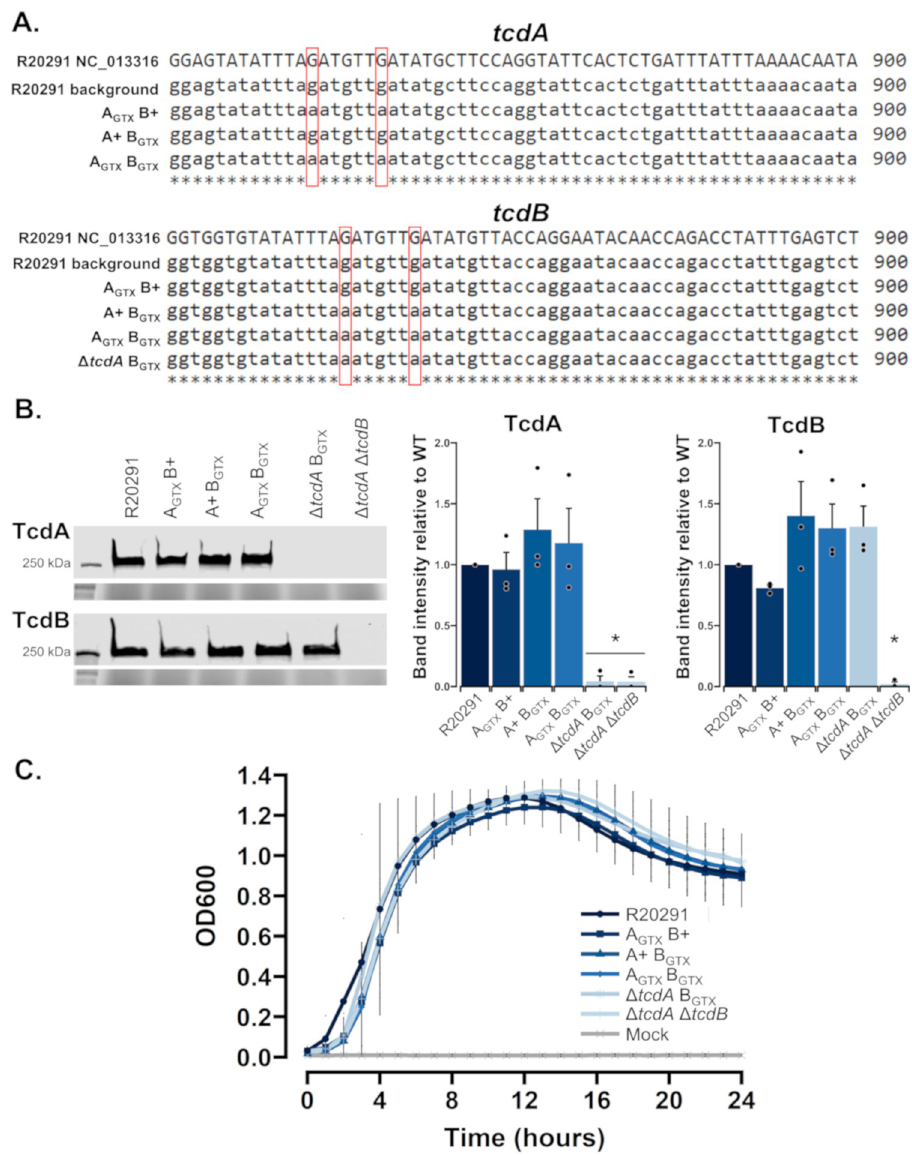
Fig 1. In vitro characterization of C . difficile mutants. (A) tcdA and tcdB gene alignments of mutant and wildtype strains to the reference genome of R20291. Red boxes highlight SNMs that deactivate GT catalytic activity. (B) Representative Western blot images of mutant and wildtype strains to confirm secretion (or lack thereof) of TcdA and TcdB. Images directly below each Western blot are stain-free gel images shown as loading controls. The graphs show densitometry analyses from Western blot experiments ( n = 3). Dots signify each replicate, bars denote the mean, and error bars represent the standard error of the mean. Significant differences were determined by Tukey’s HSD ( � p < 0.05). (C) In vitro growth curves of each strain and mock-inoculated controls ( n = 5 per treatment) cultured in BHIS for 24 hours. Dots are the average at each given timepoint, and the error bars depict the 95% confidence interval. Finally, we confirmed mutant and wildtype toxin function in vitro using cell rounding assays. Strain supernatants were obtained from bacteria cultured in toxin-inducing TY medium, followed by centrifugation and filter sterilization to remove cell contaminants. Dilu- tions of strain supernatants, TY, and purified recombinant TcdA (100 pM) and TcdB (1 pM) were placed into individual wells each containing 20,000 Vero cells and cytopathic rounding